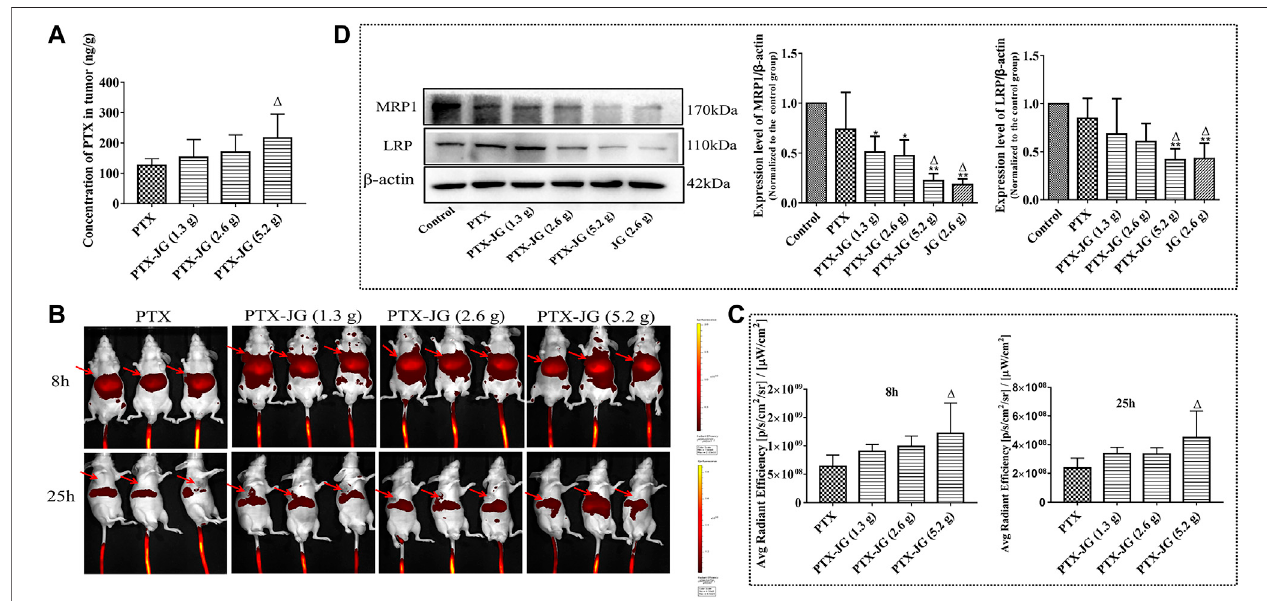
FIGURE 6 | Effect of the combination of JG on the distribution of PTX in tumor. (A) : Content of PTX in tumor detected by HPLC-MS (n = 6). (B) : Fluorescence intensity near the tumor at 8 and 25 h after the combination of cy5.5-PTX with JG were detected with in vivo imaging system (n = 3), and the red arrows represented the location of the tumor. (C) : Region-of-interest (ROI) fl uorescence intensities in tumor at 8 and 25 h (n = 3). (D) : Protein expression MRP1 and LRP were detected by Western blotting (n = 3). Values are expressed as the mean ± SD. # p < 0.05, ## p < 0.01, vs Control group; △ p < 0.05, △△ p < 0.01, vs PTX group.